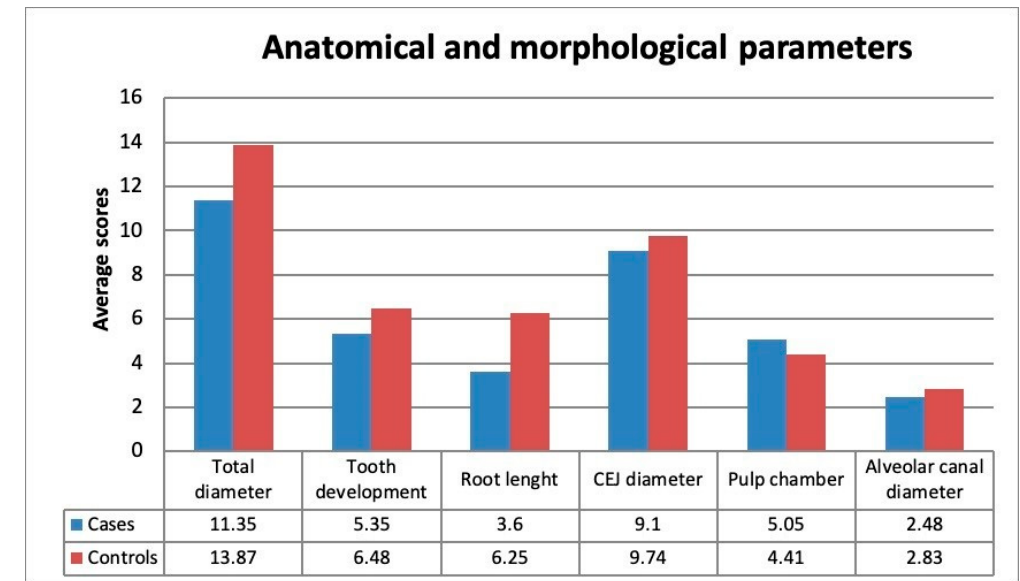
Figure 2. Anatomical and morphological parameters. Data are from the lower third molar germ and adjacent anatomical structures.